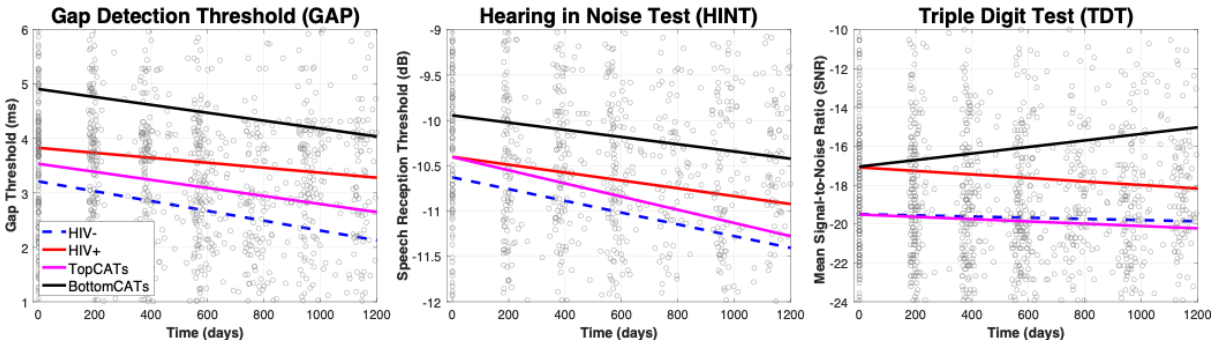
Figure 1. Trajectory of central auditory tests over time. Time 0 is the first visit in the study. Subjects were tested at roughly 6-month intervals thereafter. The blue dashed line shows the slope of the HIV-negative group, the red line shows the slope of the HIV-positive group, the magenta line shows the slope of the TopCATs group, and the black line shows the slope of the BottomCATs group. GAP, HINT, and TDT scores were used in combination to create the TopCATs and BottomCATs groups. The lines were fit to the data using linear fitting procedure in MATLAB. CAT: central auditory test; TopCATs: HIV-positive individuals in the top 20% of CAT scores; BottomCATs: HIV-positive individuals in the bottom 20% of CAT